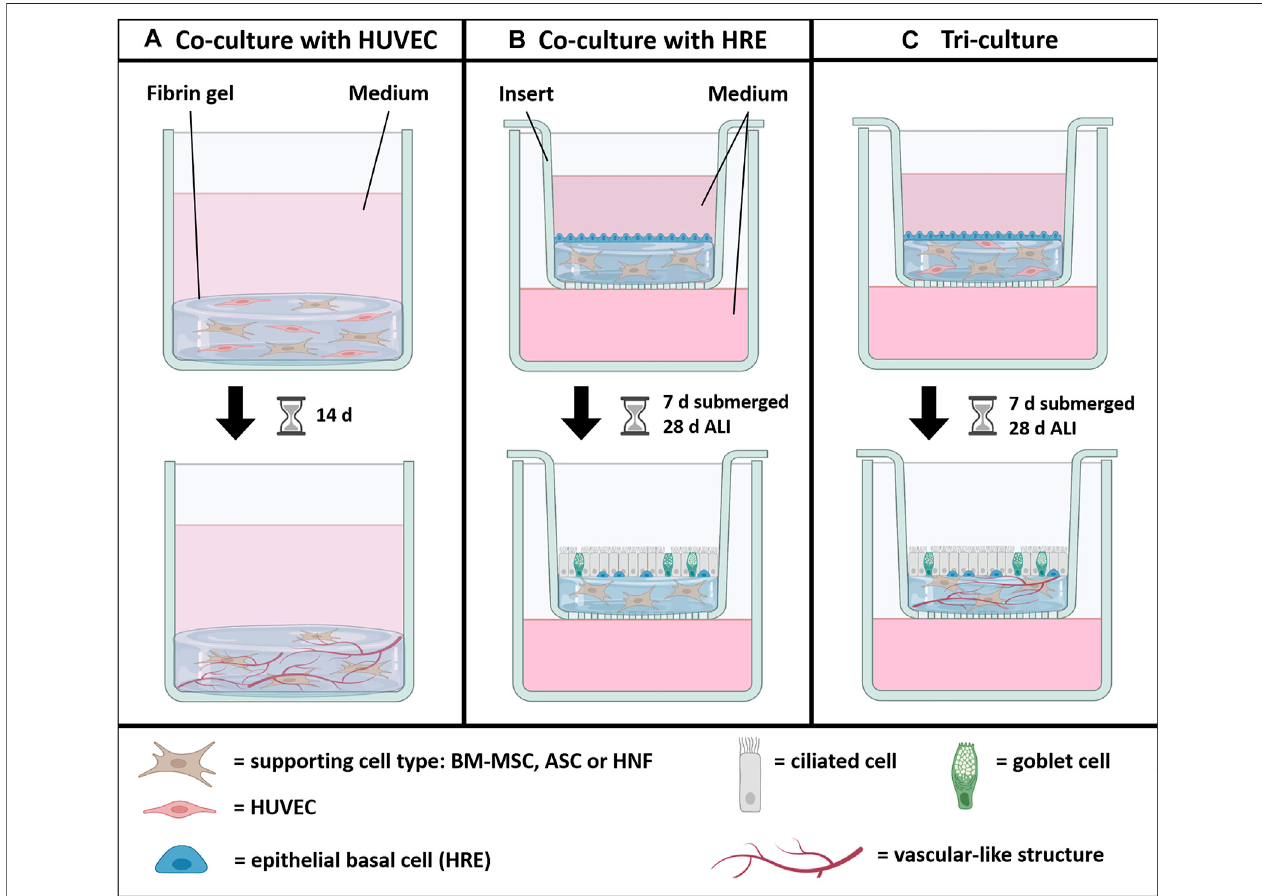
FIGURE 1 | Graphical abstract. One of the supporting cell types BM-MSC, ASC or HNF was combined with either HUVEC (A) , HRE (B) or both (C) to investigate thein fl uenceonformationofvascular-likestructuresmediatedbyHUVECandonmucociliarydifferentiationofHRE.HUVECandthesupportingcelltypeswereseededin fi bringelwhileHREwereseededontop.AllcultureswithHREweredifferentiatedatair-liquidinterface(ALI)conditionsfor4 weeksafterasubmergedproliferationperiod for 1 week. Co-cultures with HUVEC were cultured for 2 weeks. Figure created with BioRender.com.